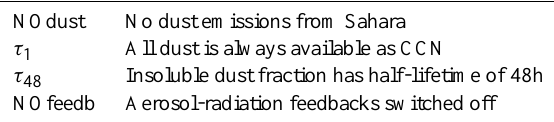
Table 1. Overview of simulated scenarios. NOdust